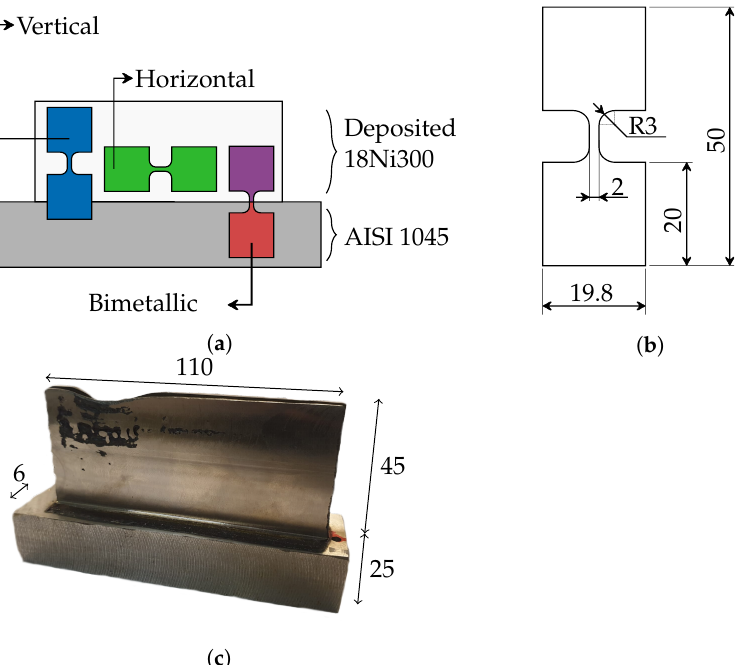
Figure 4. Tensile specimen manufacturing overview: ( a ) specimen configuration within printed geometry; ( b ) its geometry in millimetres, with a thickness of 2mm; ( c ) the deposited structure on top of the AISI 1045 baseplate, with its dimensions annotated in